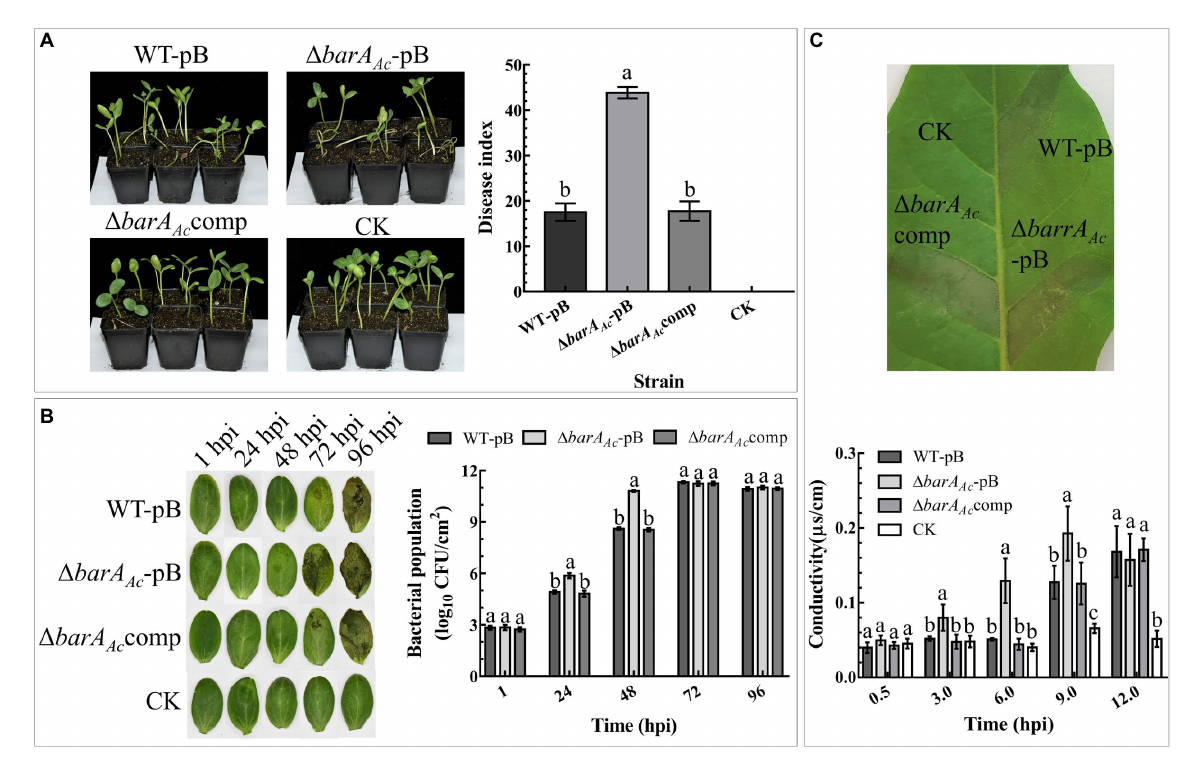
FIGURE 2 The deletion of barA Ac affected the virulence, host proliferation, and ability to induce a hypersensitive response (HR) on tobacco ( Nicotiana tabacum ). (A) Watermelon seeds were inoculated with Acidovorax citrulli wild-type strain WT-pB, Δ barA Ac -pB, and Δ barA Ac comp by soaking. After 18 days, the disease indices of the germinated seedlings were determined. Sterilized water was used as a negative control (CK). The bar chart shows the average disease index for 3 replicates, with 14~18 seedlings in each replicate. The error bar represents the standard deviation, and different letters on each treatment indicate significant differences (ANOVA, p < 0.05). (B) Determination of the bacterial population levels of WT-pB, Δ barA Ac -pB, and Δ barA Ac comp in watermelon cotyledons. The data represent the mean ± standard deviation of the bacterial population levels. Different letters on each treatment at each time point indicate significant differences (ANOVA, p < 0.05). (C) The leaf photo shows the HR induced by test strains on N. tabacum leaves. The photo was taken at 24 hpi. The bar chart represents the electrolyte leakage caused by the test strains in N. tabacum leaf tissue, and sterile water treatment was used as a negative control (CK). The error bar represents the standard deviation. Different letters on each treatment at each time point indicate significant differences (ANOVA, p <